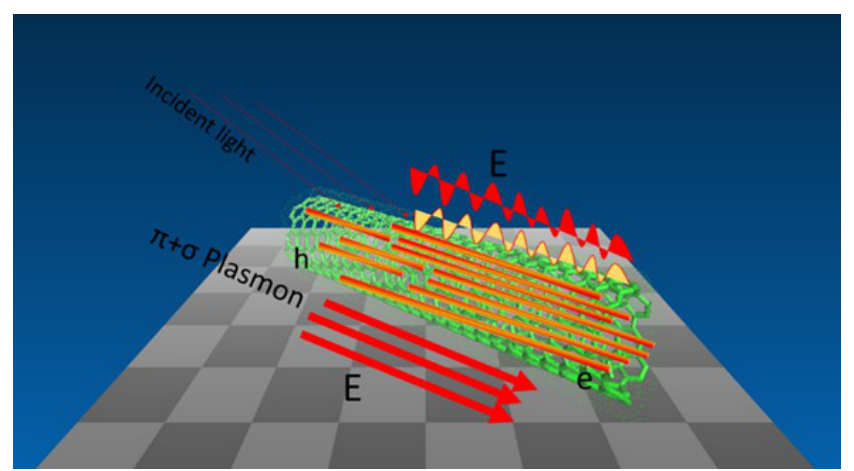
Figure 13. Scheme of hybrid GNWs/SWCNTs as SERS substrate for trace level detection